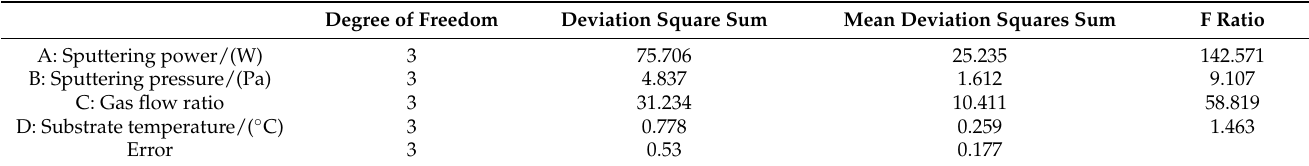
Table 9. Variance analysis of film deposition rate test results of Si 3 N 4 film.